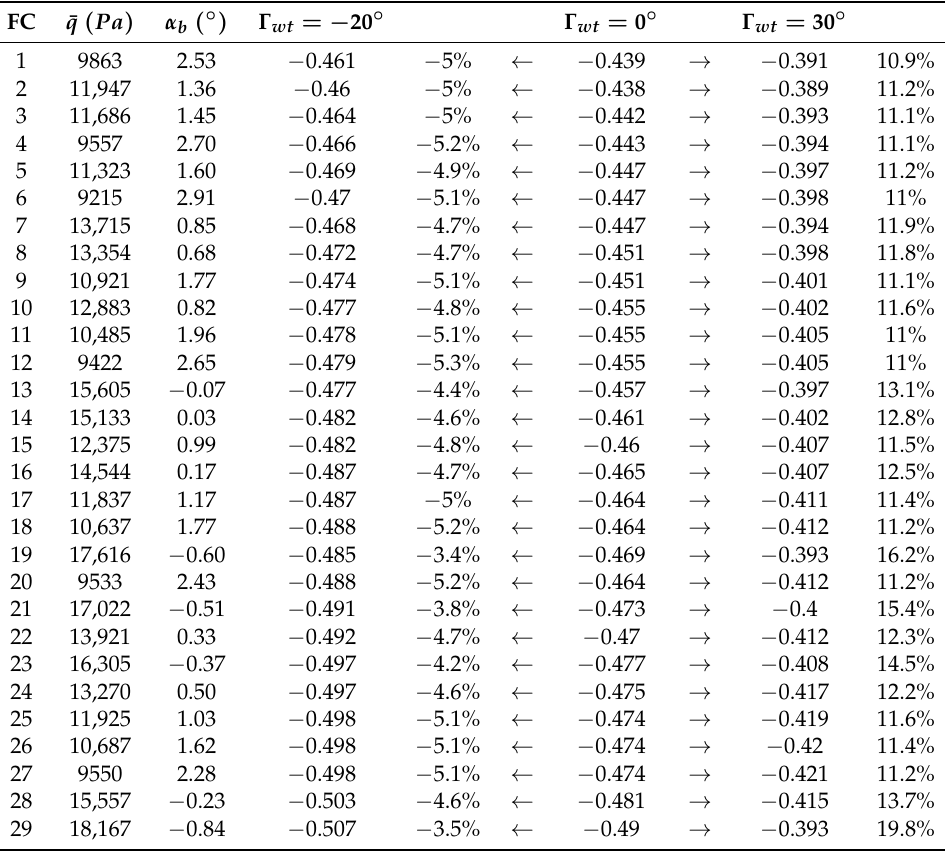
Table A3. C l Identification results—20% wingtip rigid p